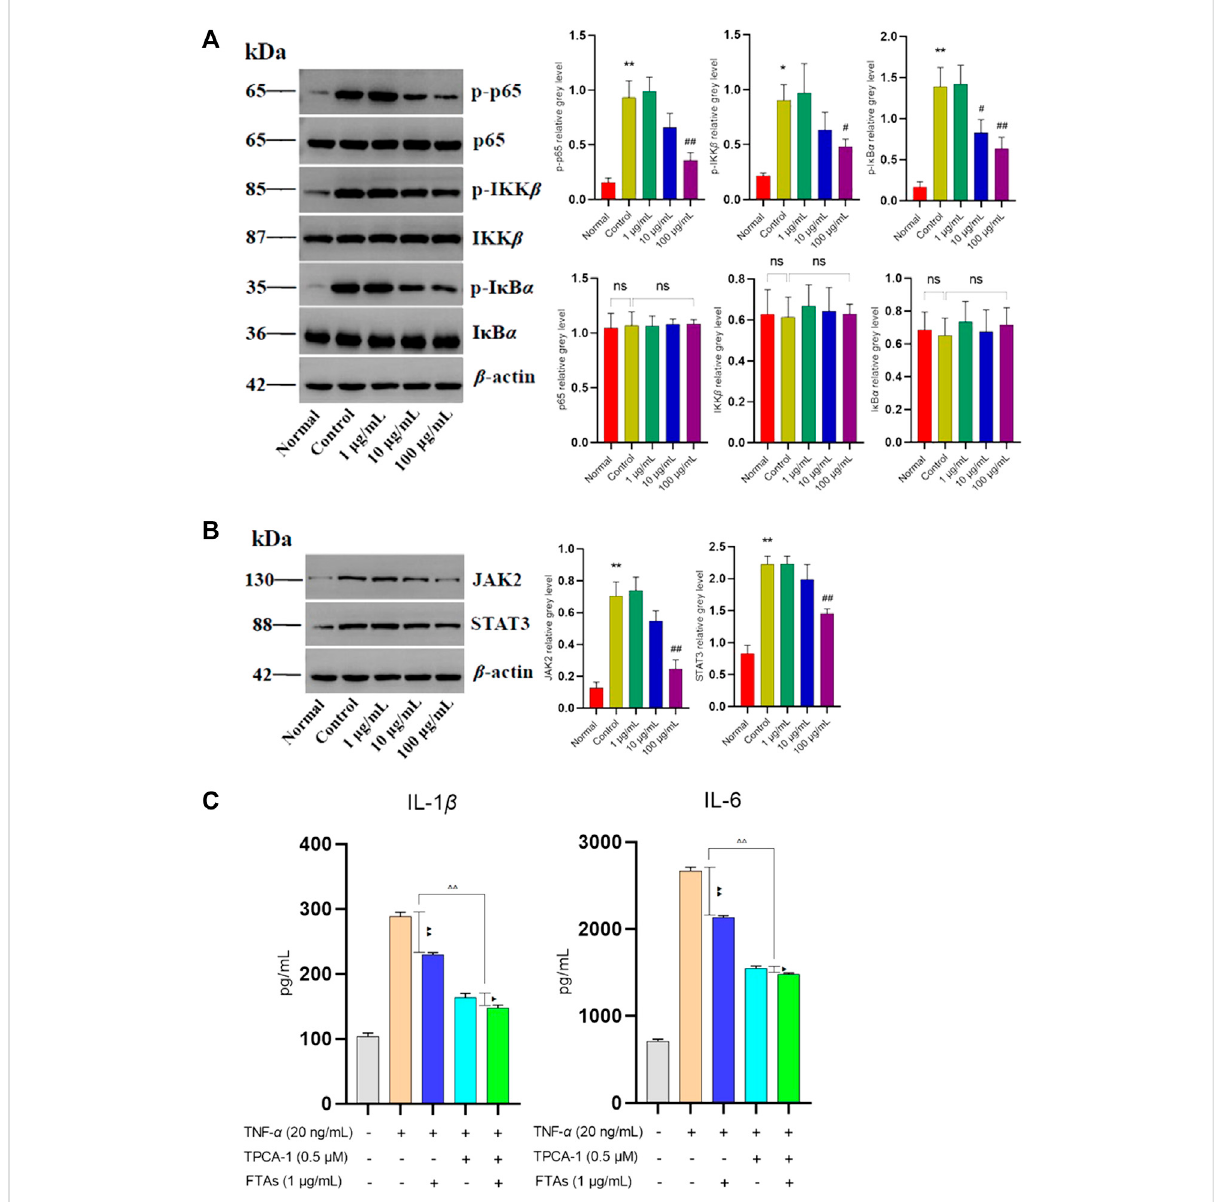
The effects of FTAs on activation of NF- κ B and JAK/STAT signaling pathways in TNF- α -induced MH7A cells. MH7A cells were intervened by corresponding concentrations of FTAs in absence or presence of 20 ng/ml TNF- α for 24 h, and then the protein signal intensity of p-p65, p65, p-IKK β , IKK β , p-I κ B α , and I κ B α in NF- κ B (A) and JAK2, STAT3 in JAK/STAT (B) signaling pathways were measured by western blot. (C) The inhibitory effects of FTAs on IL-1 β and IL-6 in absence or presence of TPCA-1 were measured by ELISA kits. The experimental results were recorded